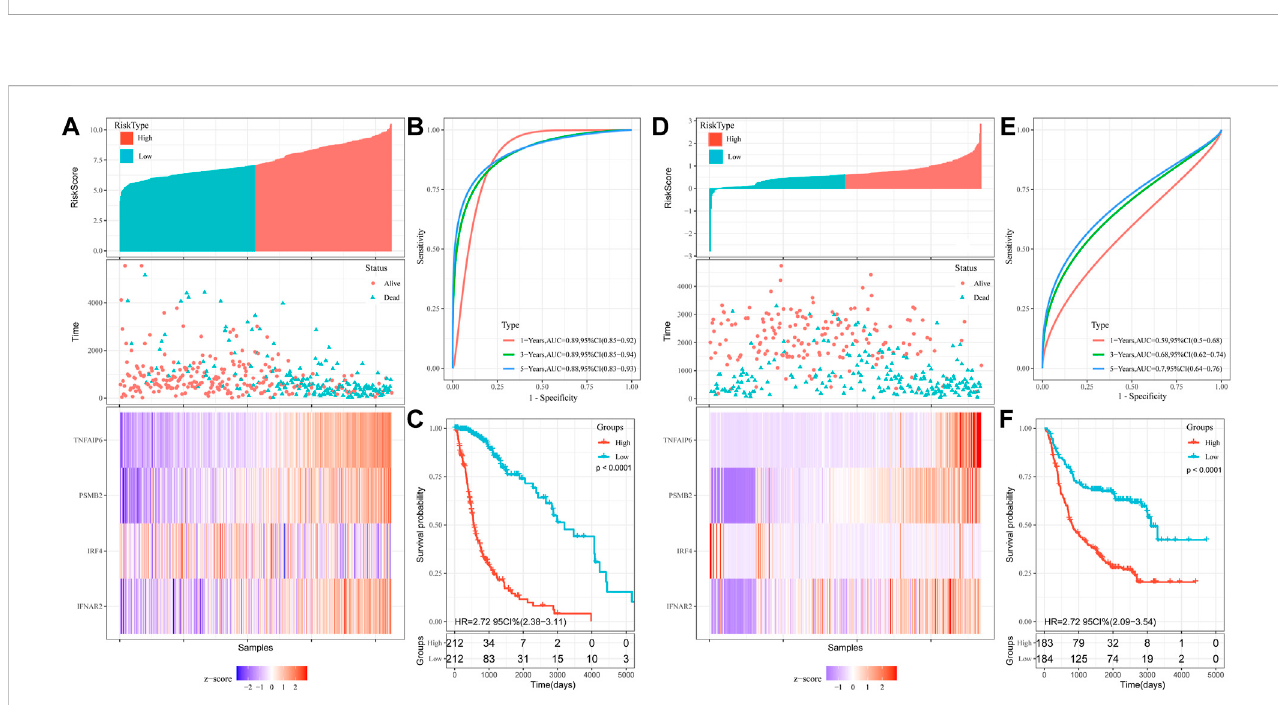
FIGURE 3 ConstructionofOSpredictionmodelbasedon4genesintheTCGAdataset: (A) Heatmapsoffourgenesinthehighandlowriskscoregroups. (B) Time- dependent ROCcurvefor OS. (C) Kaplan-Meieranalysis.ValidationofOSprediction modelbasedon4genesinCGGAdataset: (D) Heatmapsoffourgenesin the high and low risk score groups. (E) Time-dependent ROC curve for OS. (F) Kaplan-Meier